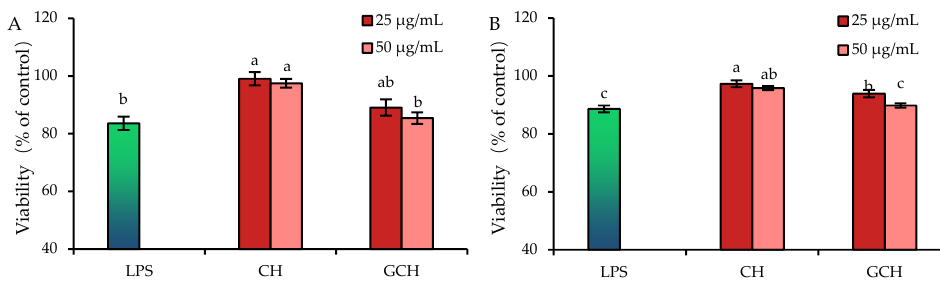
Figure 2. Viability values (%) of the IEC-6 cells treated with casein hydrolysate (CH) and glycated casein hydrolysate (GCH) for 12 h ( A ) and 24 h ( B ), followed by 10 μg/mL LPS treatment for 24 h. The one-way ANOVA of the mean values with different lowercase letters above the columns indicates a significant difference ( p < 0.05).